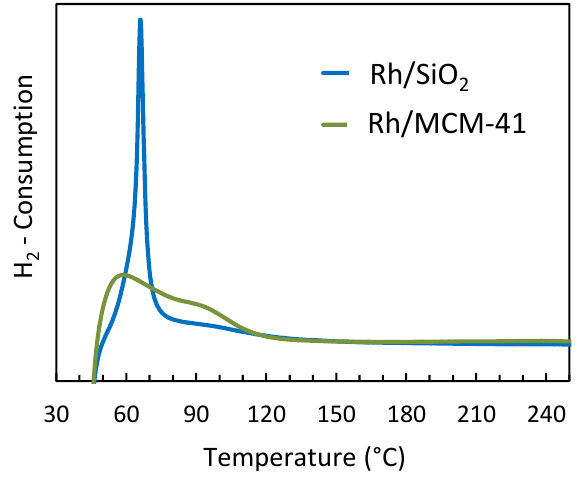
Figure 8. Temperature programmed reduction profiles of the Rh/SiO 2 and Rh/MCM-41 catalysts.